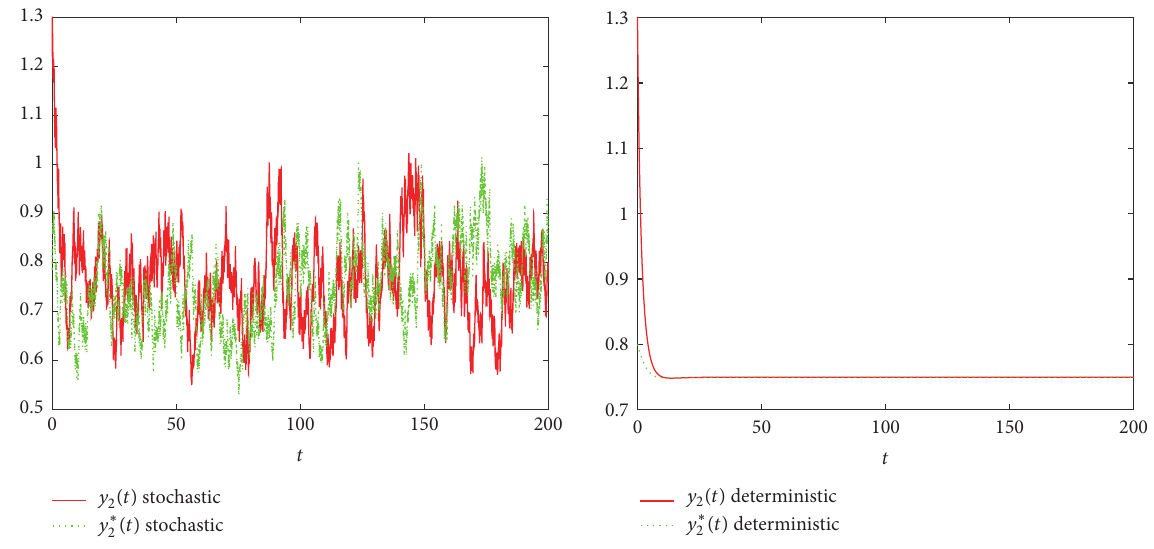
Figure 7: The path curve of 𝑦 2 (𝑡) and 𝑦 ∗ 2 (𝑡). Red: solution of model (62) for 𝛾 1 (𝜃) = (1.5,1.3, 1) . Green: solution of model (62) for 𝛾 ∗ 1 = (0.7, 0.8, 0.6)